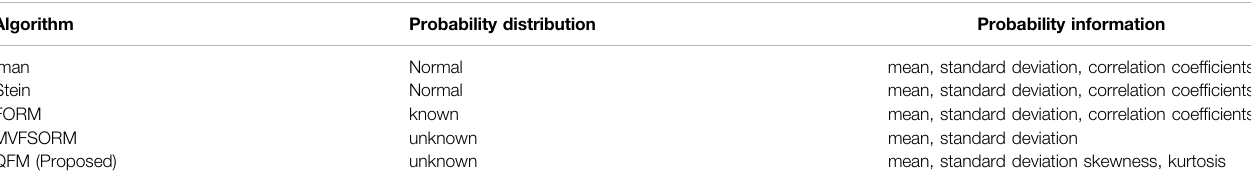
TABLE 1 | Input P robability information for the different algorithms.